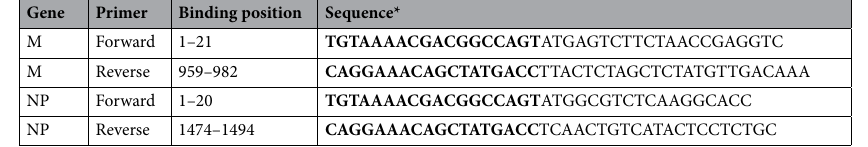
Table 3. Primers used to amplify gene segments of A(H1N1)pdm09 virus. *The sequence of the M13 tail is indicated in